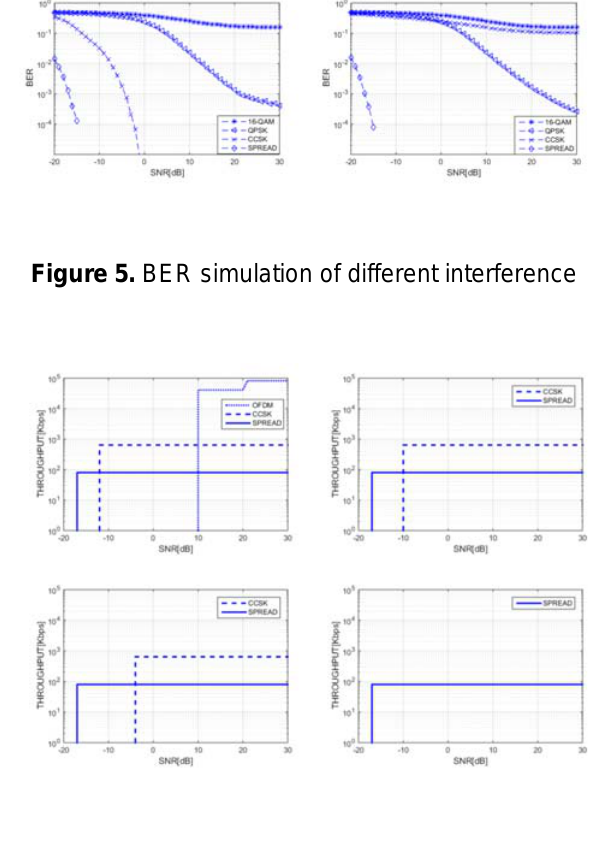
Figure 6. Throughput simulation of different